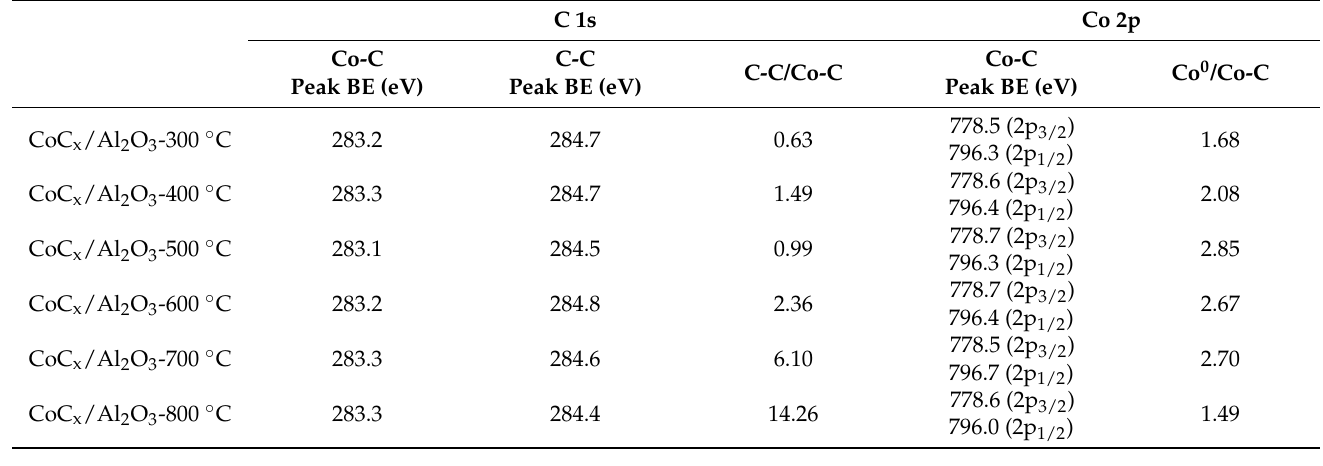
Table 1. XPS data analysis of C 1s and Co2p peaks of CoC x /Al 2 O 3 catalysts.